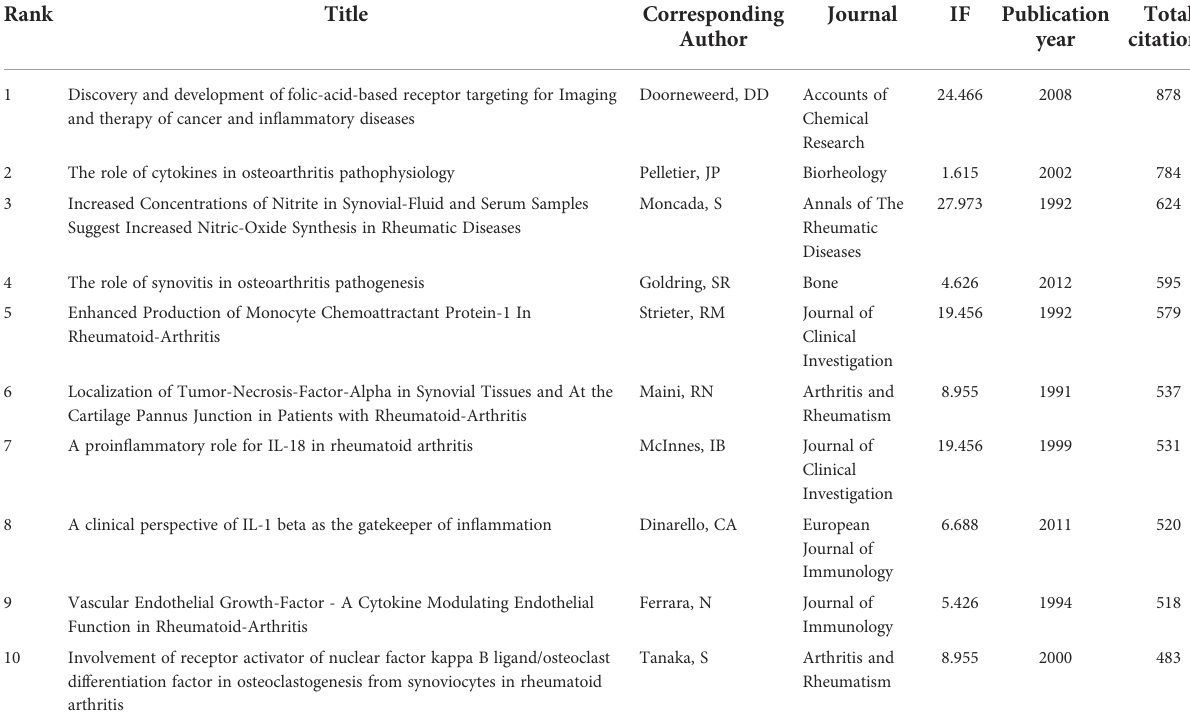
TABLE 4 The top 10 documents with the most citations in the fi eld of macrophages associated with